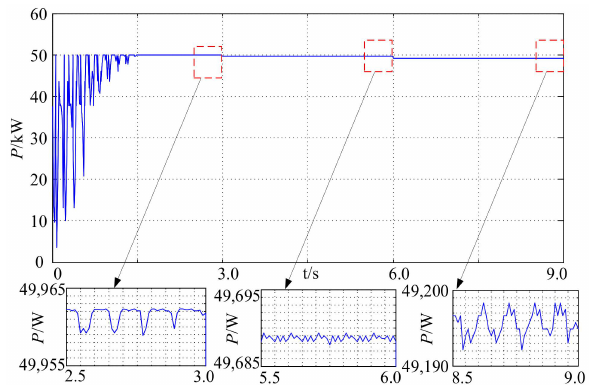
Figure 13. Power waveform of FA under gradual change